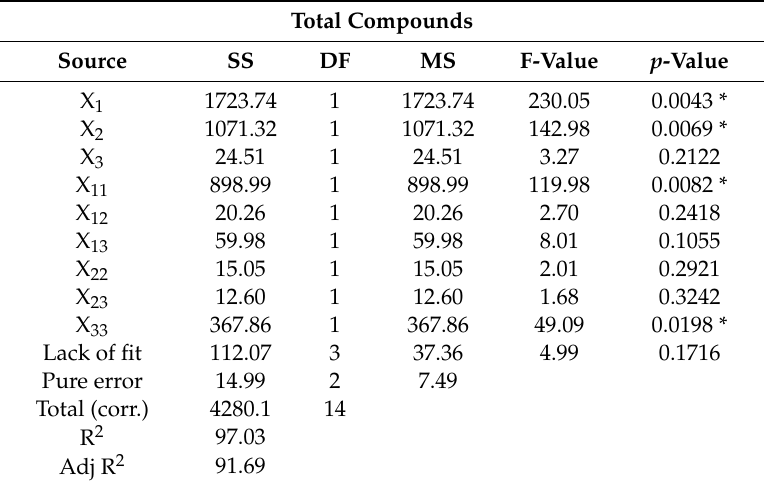
Table 2. ANOVA test for the response variable of total